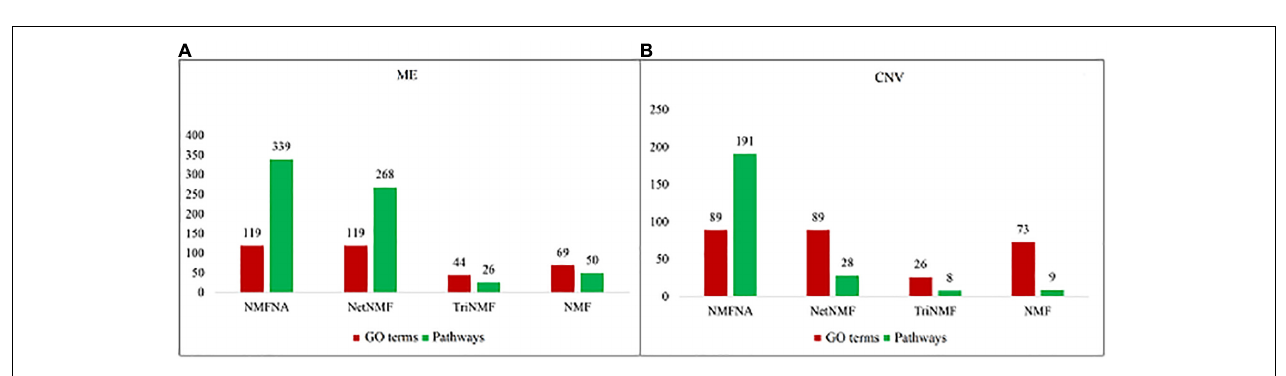
FIGURE 3 | Numbers of GO terms and pathways obtained from enrichment analyses of ME and CNV core modules that identified by compared methods. (A) Represents the details of the ME core module and (B) represents the details of the CNV core